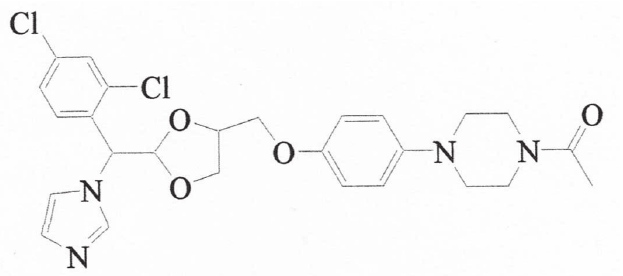
FIGURE 1 - Chemical structure of